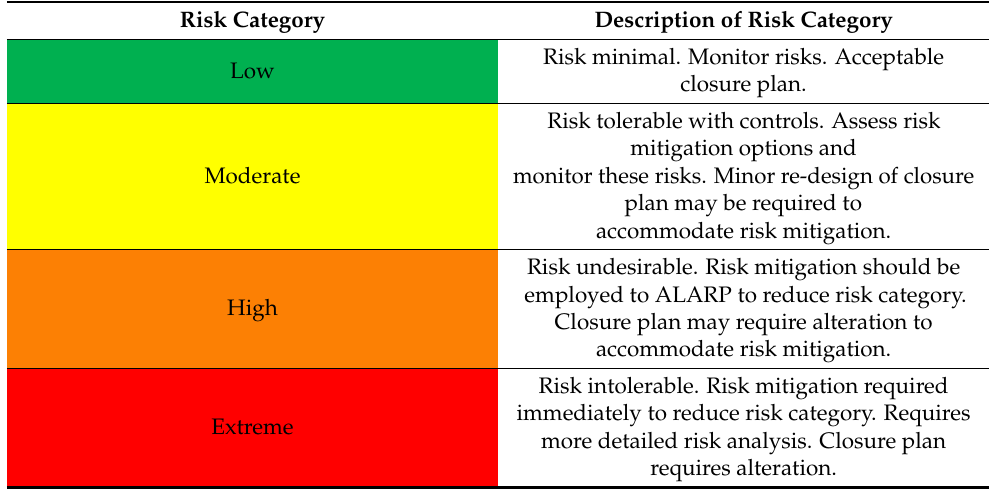
Table 3. Risk category (Reprinted from Schafer et al.